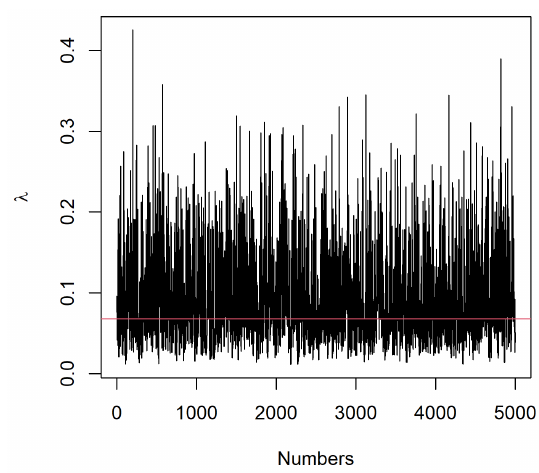
Figure 6. The Markov chains of λ